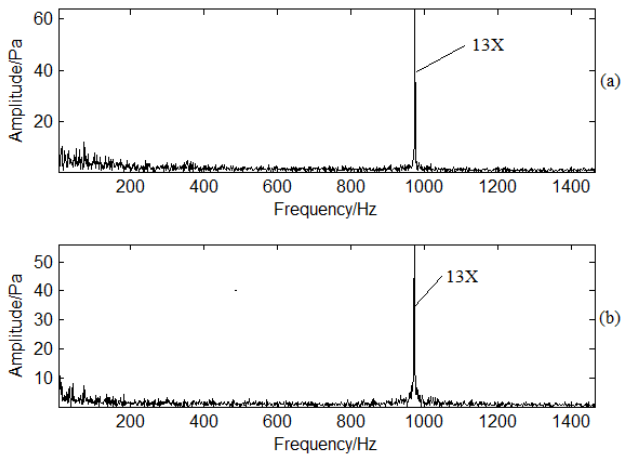
Figure 12. PP frequency domain signal analysis under different working conditions: ( a ) Normal conditions; ( b ) Crack conditions.